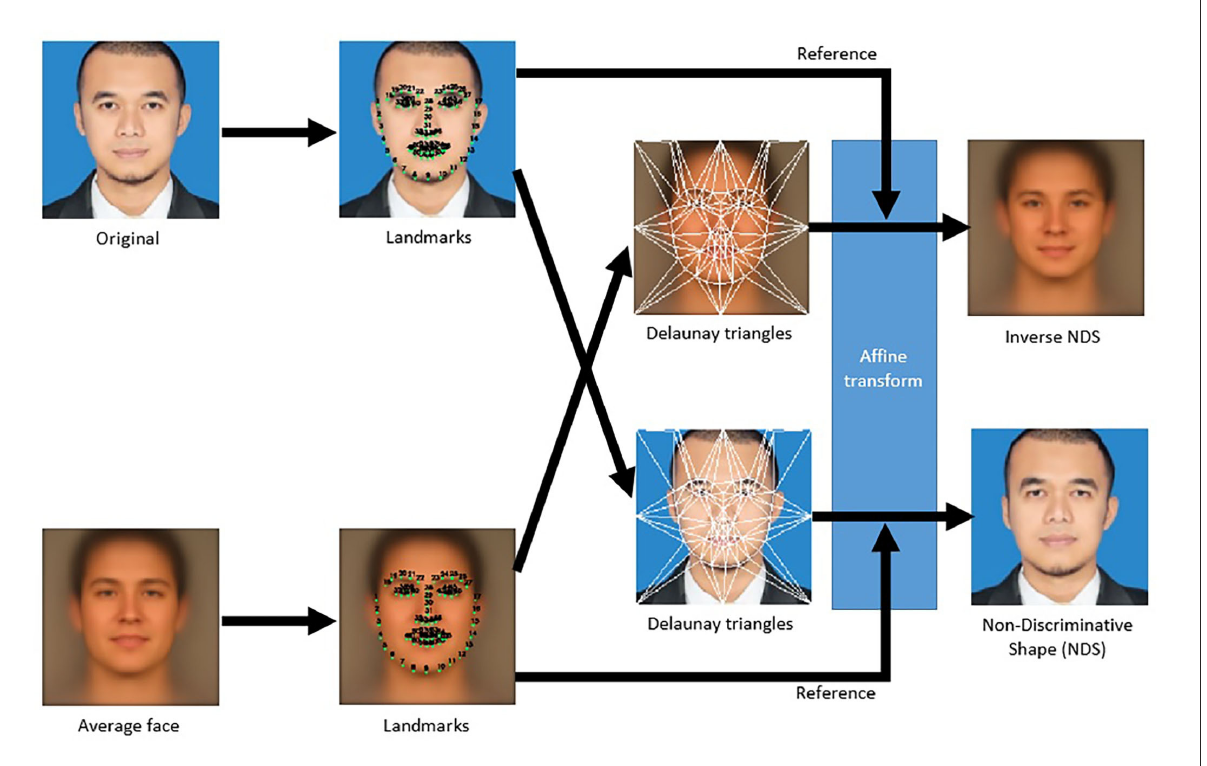
FIGURE4 The modified morphing for NDS and iNDS face analysis.